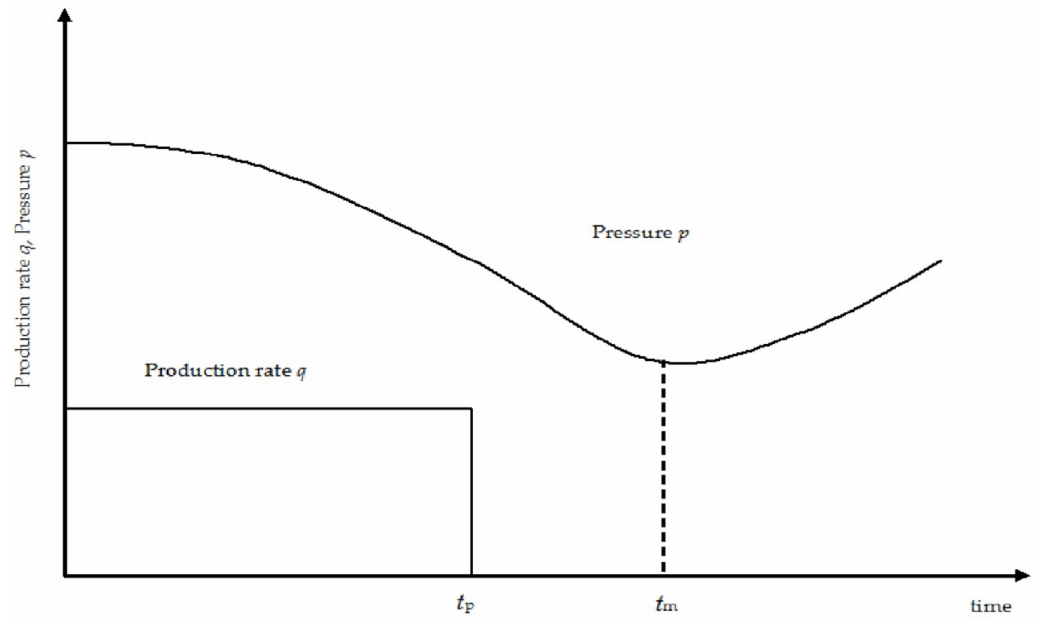
Figure 1. Active well production rate and observation well pressure of interference